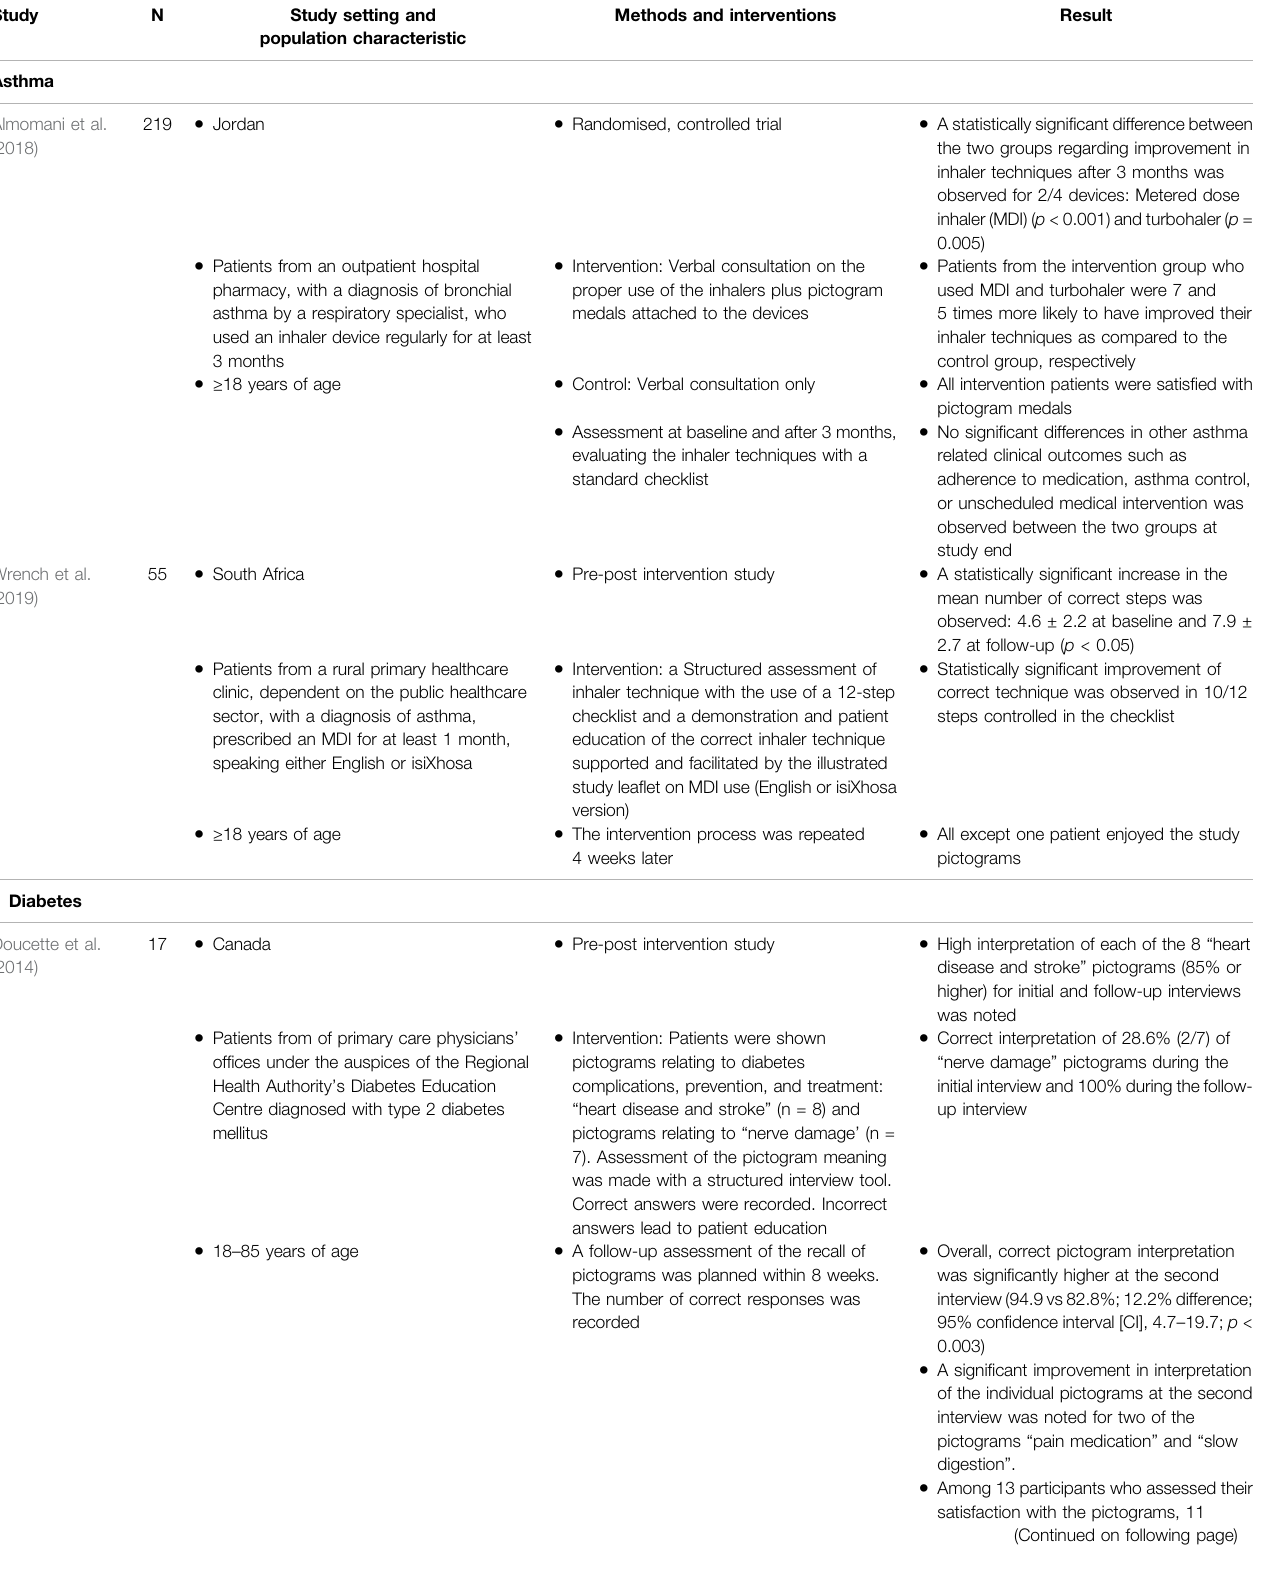
TABLE 1 | Pictograms in the pharmaceutical care of chronically ill